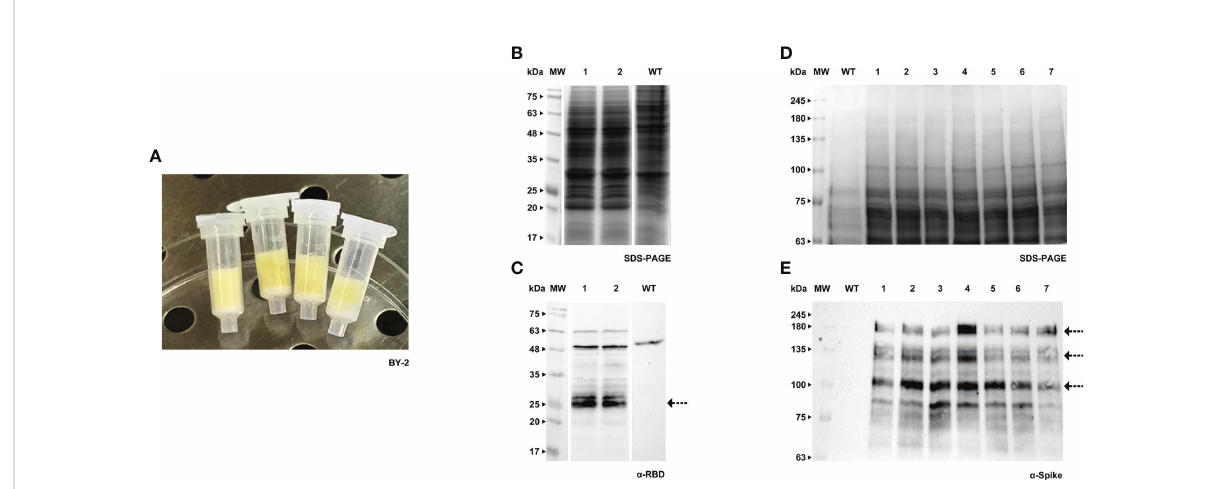
FIGURE 1 Transient expression of RBD and Spike in BY-2 cell packs. (A) Receiver columns with BY-2 cells. (B) Stained gel containing total protein extract of two independent BY-2 cell lines in fi ltrated with pTRA-RBD, WT - wild type. (C) Corresponding western blot (WB) with anti-RBD antibody. (D) Stained gel containing total protein extract of seven independent BY-2 cell lines in fi ltrated with pTRA-Spike, WT - wild type. (E) Corresponding WB with anti-Spike antibody.